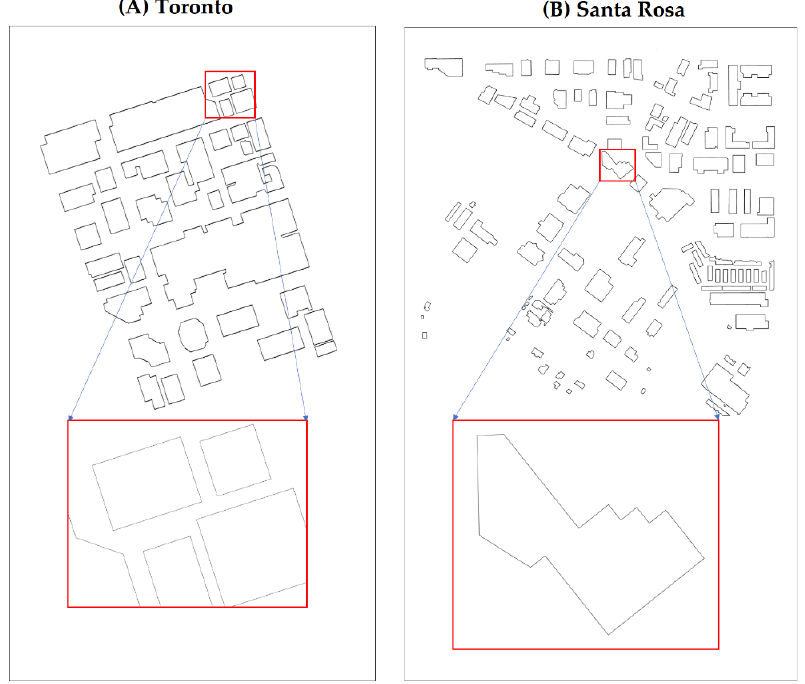
Figure 16. Regularized Building Footprint and magnified view. ( A )Toronto. ( B ) Santa Rosa.